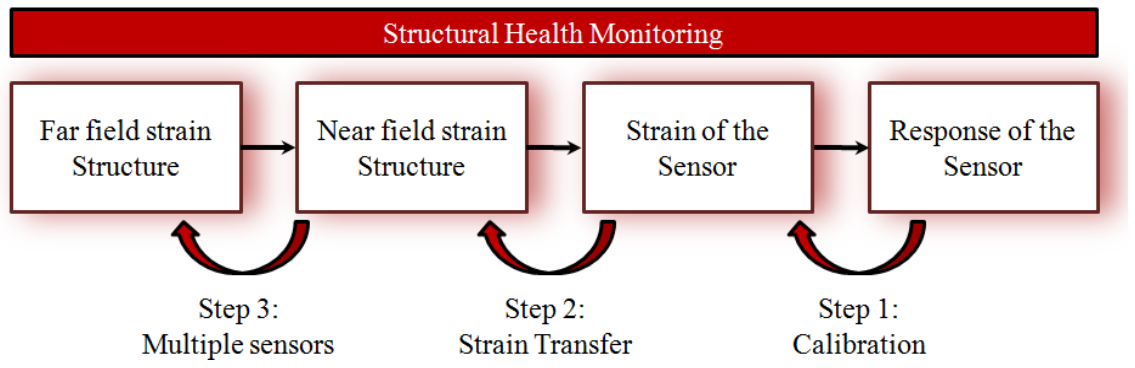
Figure 4. Flow chart of the different steps necessary for structural health monitoring using an embedded optical fibre sensor